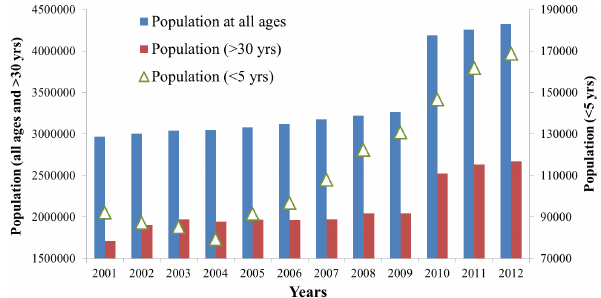
Figure 7. Yearly registered population for all ages and of > 30years and < 5years in the Beijing central